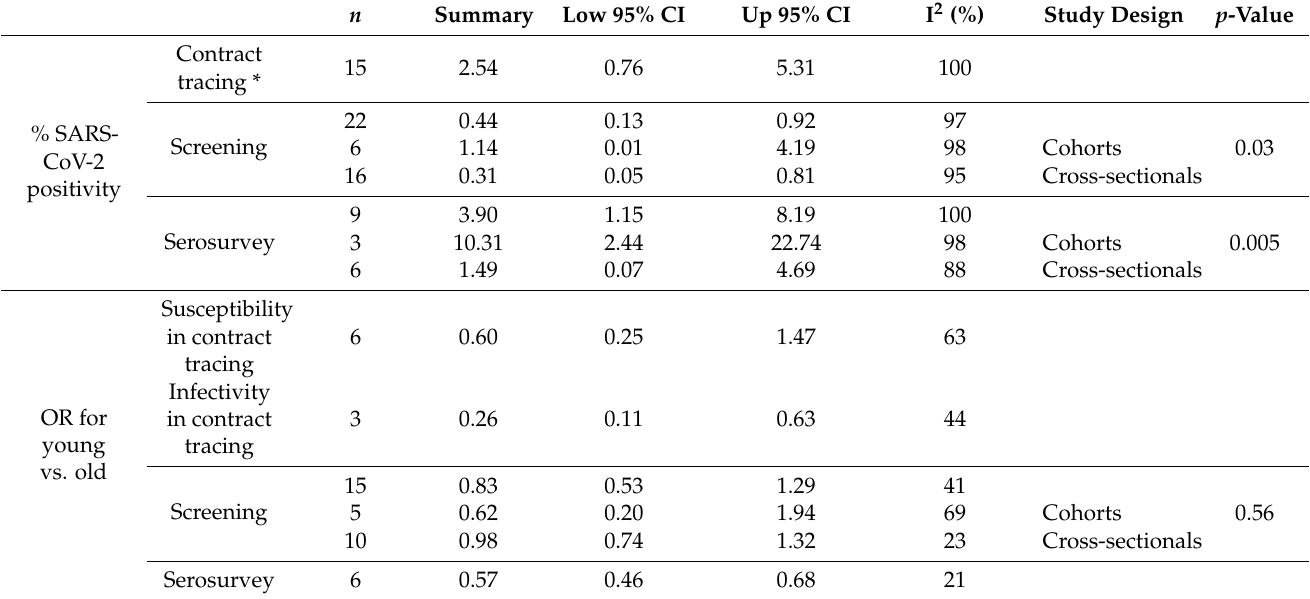
Table 1. Summary